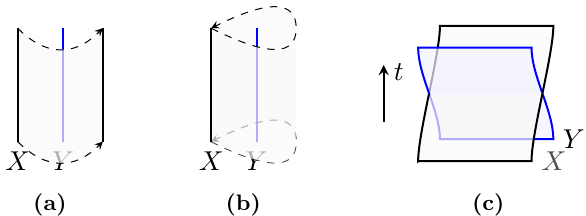
Figure 2. (a): moving a string X around Y in the 3d space is a braiding of X and Y ; (b): the trajectory of a double braiding is a cylinder; (c): the braiding is a 1+0D defect embedded in the 3+1D